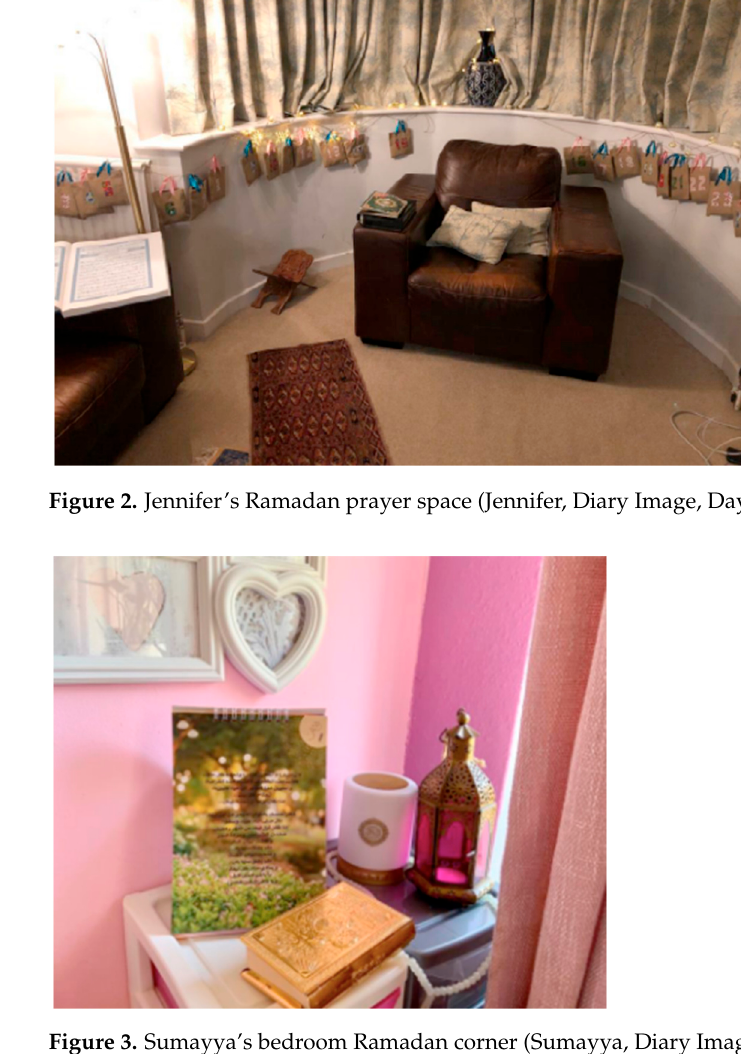
Figure 4. Sumayya’s living room Ramadan corner (Sumayya, Diary Image, Entry 2).